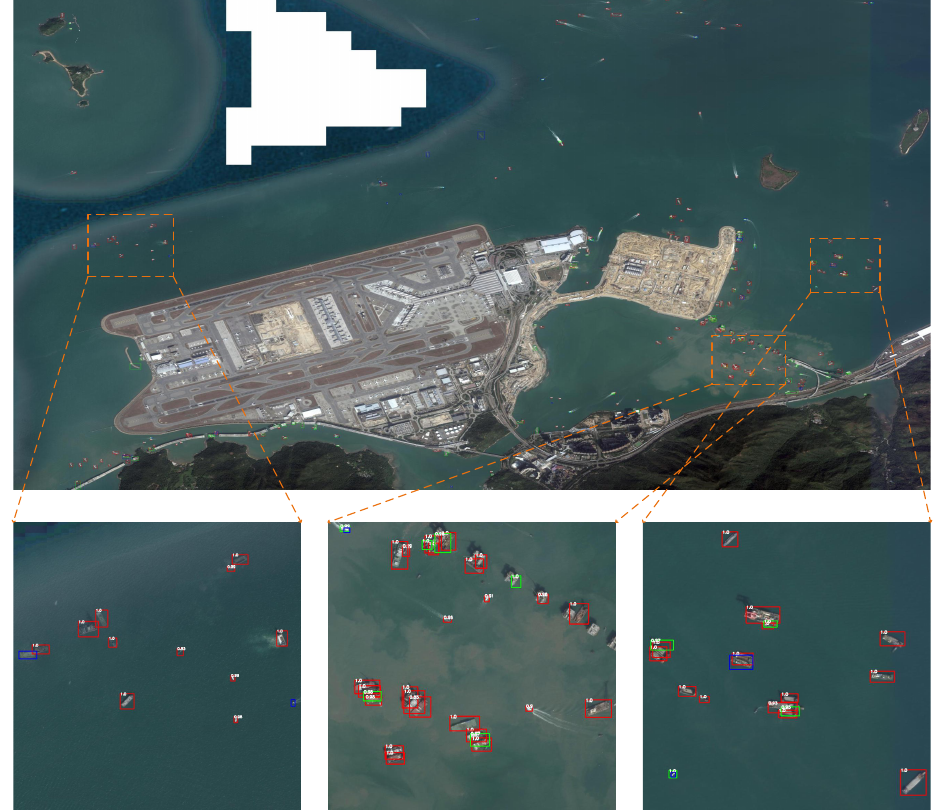
Figure 11. The detection results of IMAGE1. The true positives, false positives and false negatives are indicated by red, green and blue rectangles. The top left corner of the rectangle shows the